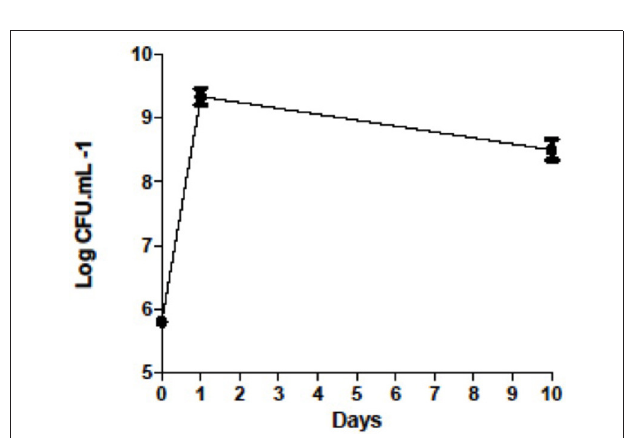
FIGURE 3 | Lactobacillus rhamnosus viability during diluted grape beverage 24h fermentation. Initial inoculum was 10 6 CFU/mL Formulation was storage for10 days at 4 ◦